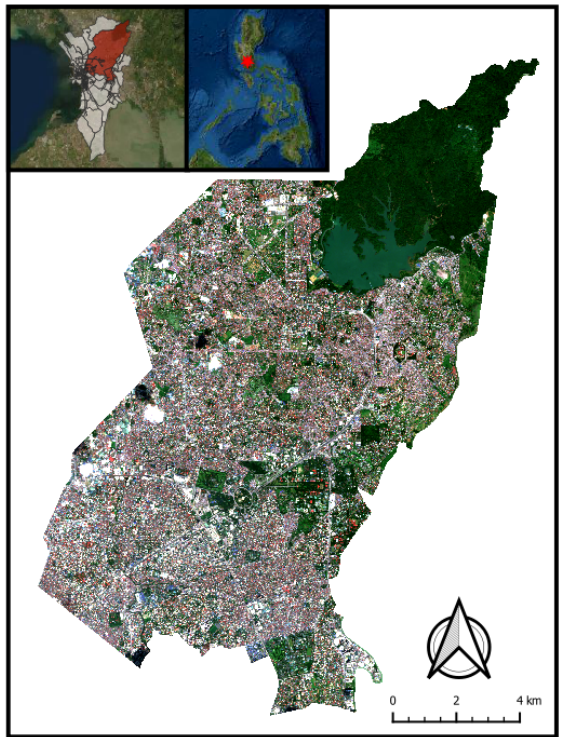
Figure 1 . Sentinel-2 true color composite (RGB 432) image covering Quezon City taken on October 25, 2016, with ESRI tile insets showing the Metro Manila area (upper left) and the Philippines (upper